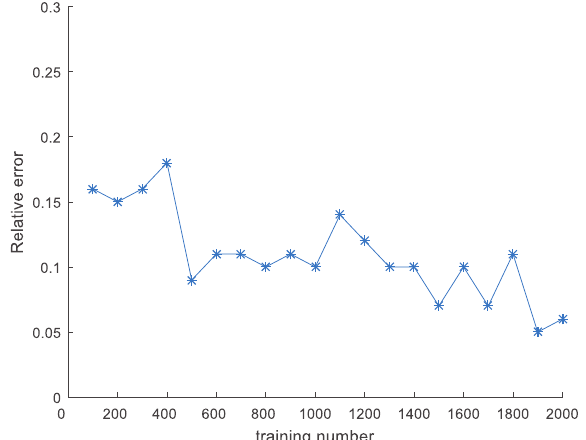
Figure 6. Test accuracy comparison of learning algorithms for the FNNRW. The accuracy of the improved FNNRWs method is superior to the FNNRW algorithm in the test dataset in terms of various training durations.